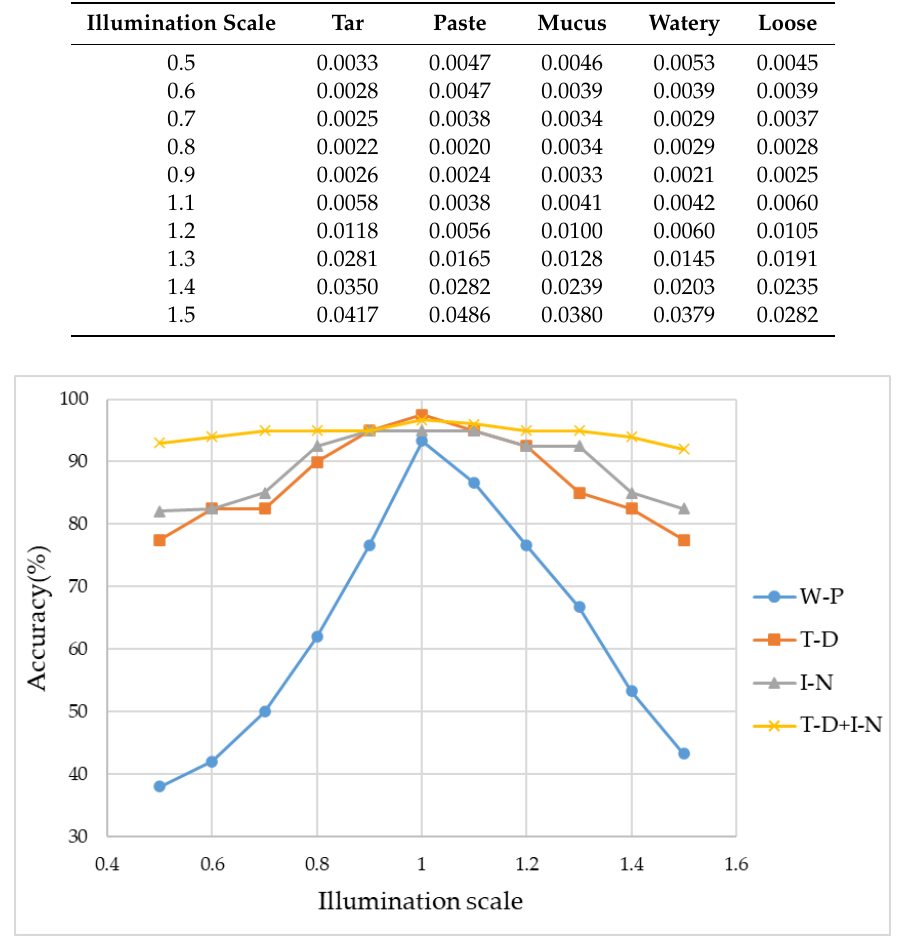
Table 1. Normalized Hamming distances between the segmented images under different illuminations. Illumination Scale